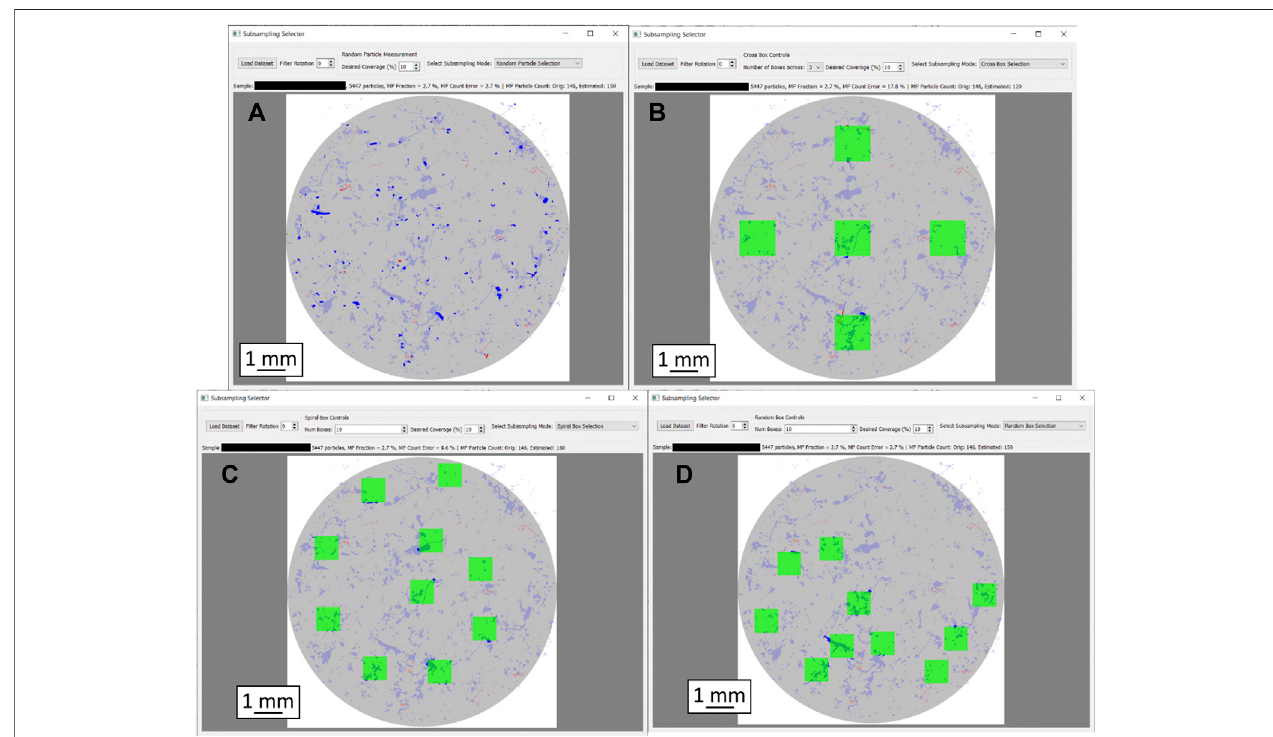
FIGURE 3 | Graphic representation of the particle distribution heterogeneity as well as different subsampling approaches with 10% fi lter coverage each. Filter diameter is 10 mm in each case. (A) : Random subsampling, (B) : Box selection, cross layout, (C) : Box selection, spiral layout, (D) : Box selection, random layout. MP particles are shown in red, others in blue. Particles missed by the respective subsampling method are displayed in pale colors; only the particles in strong colors were